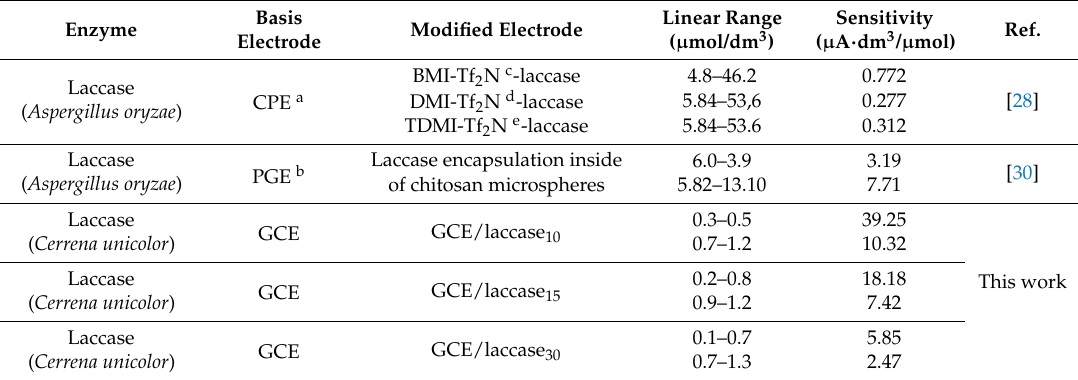
Table 2. Comparison of different biosensors designed for Rutin